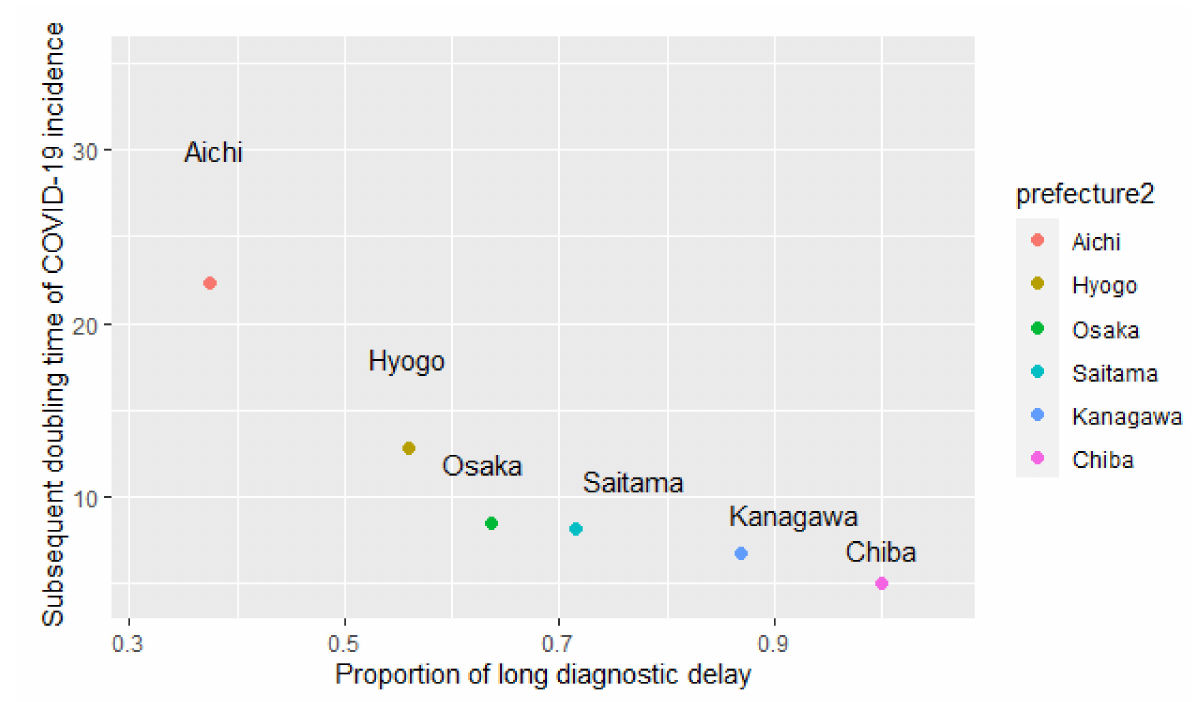
Figure 2. Geographic correlation between the proportion of long diagnostic delay for patients with unknown exposure (the 9th to the 11th week, 2020) and subsequent 14 days moving-average doubling time of COVID-19 incidence (the 12th–13th week) among the six Japanese prefectures.